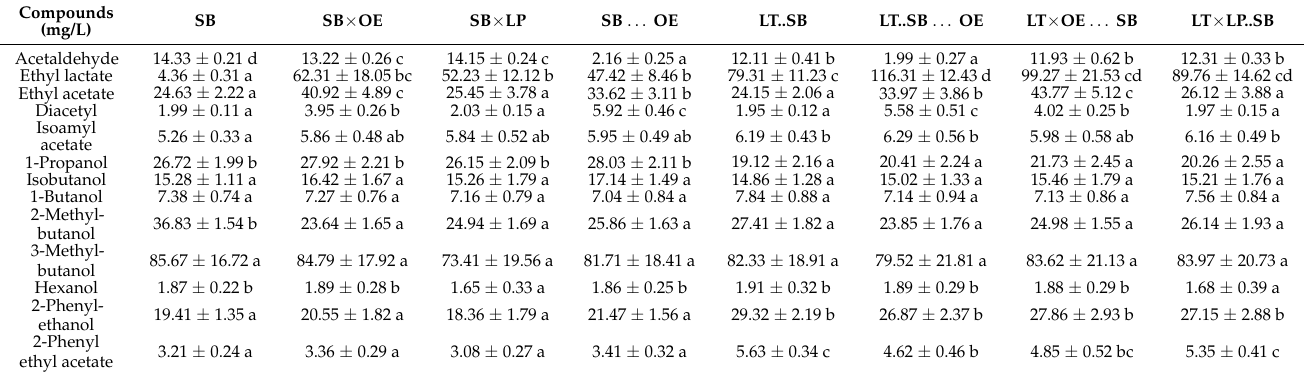
Results are mean ± SD of three replicates. Means in same row with same letter were not significantly different ( p <